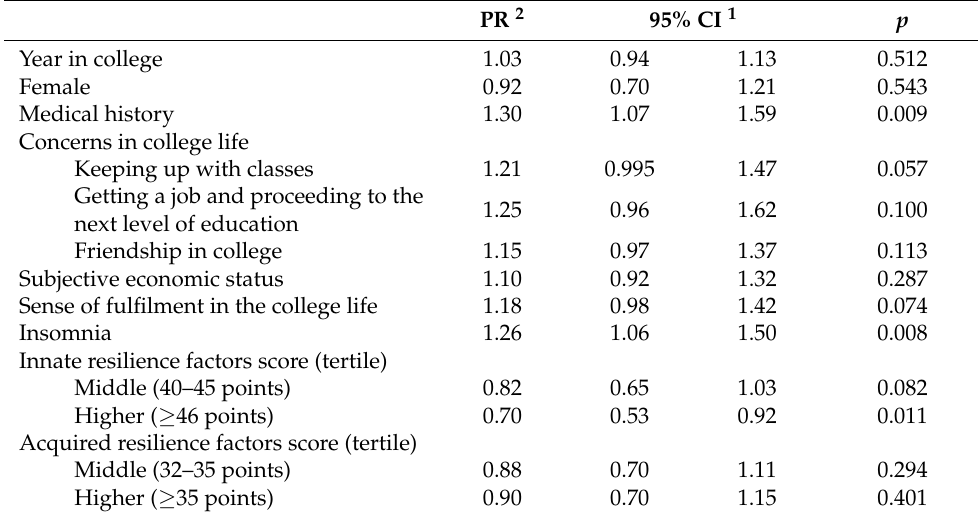
Table 4. Multivariate regression analysis after multiple imputation ( n =